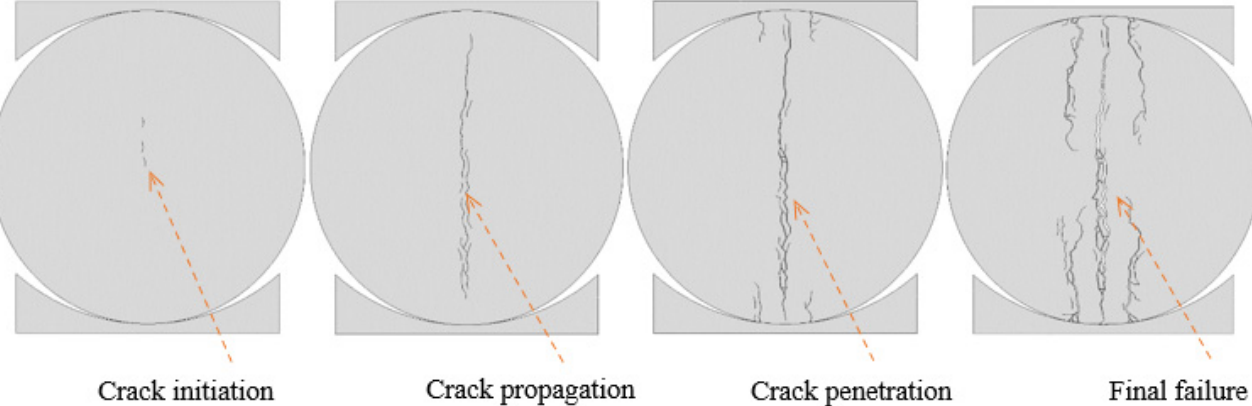
Figure 10. Failure process for the Type III Brazilian disc testing.